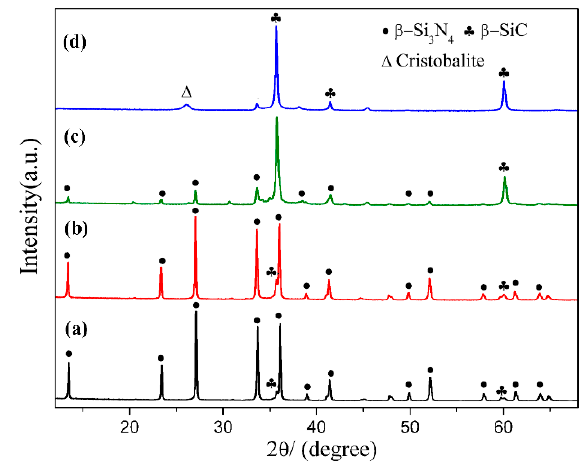
Figure 6. XRD patterns of sample S1~S4 nitrided at 1600 ◦ C for 3 h: ( a ) S1, C / SiO 2 = 2; ( b ) S2, C / SiO 2 = 2.2; ( c ) S3, C / SiO 2 = 3; ( d ) S4, C / SiO 2 =